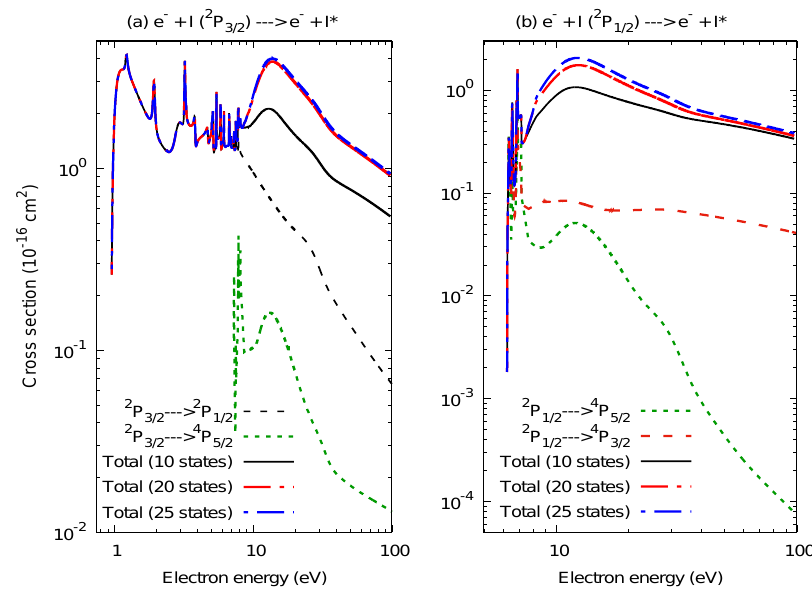
Figure 2. Electron-impact excitation cross section from ( a ) the ground state and ( b ) the first excited state of atomic iodine. The total cross sections shown are obtained by summing the partial cross sections into 10, 20, and 25 final states as shown in the legend.